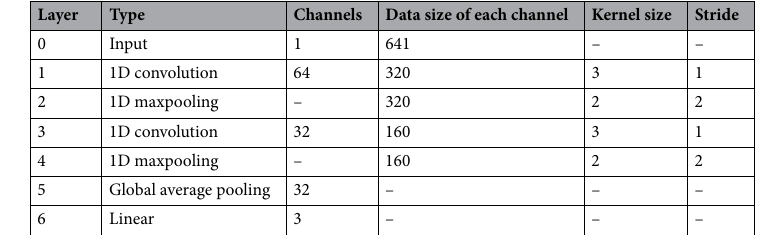
Table 4. Parameters of the proposed CNN model for electrospray mode prediction.